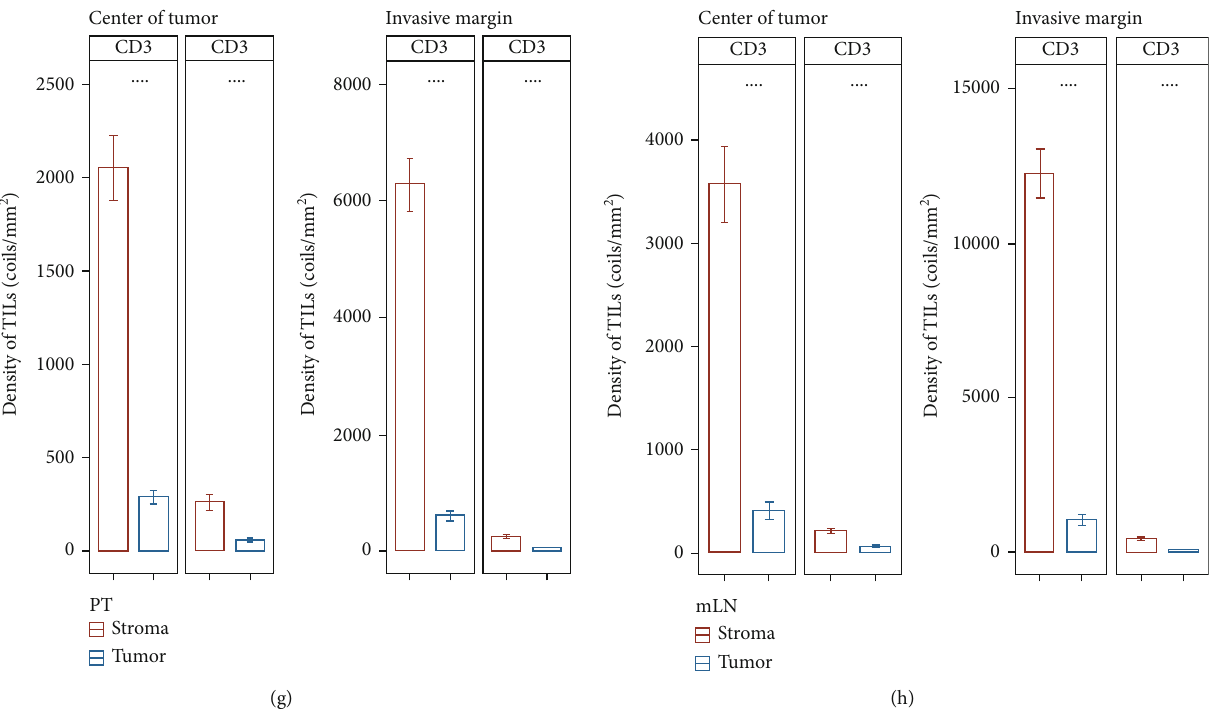
Figure 1: Multiplex immuno fl uorescence staining and multispectral imaging to visualize the expression of CD3, CD8, PD-L1, and cytokeratin (CK) in primary tumors (PTs) and metastatic lymph nodes (mLNs). (a) Fields of view (FOVs) of the center of tumor (CT) and invasive margin (IM) regions were identi fi ed at low magni fi cation ( × 10). (b) Images of representative FOVs that are categorized as CT in sections with tumor tissue being too small. (c, d) FOVs of CT region in PT (c) and mLN (d). Staining was performed for CD3 for T lymphocytes (yellow), CD8 for cytotoxic T cells (green), type II CK for epithelial cells (purple), 4 ′ -6 ′ -diamidino-2-phenylindole (DPAI) for nuclei (blue), and PD-L1 (red). (e, f) FOVs of IM region in PT (e) and mLN (f). Hand-drawn training regions allowed images to be segmented into tumor compartment (presence of cytokeratin positivity (red)) and stroma compartment (absence of cytokeratin positivity (green)). (g, h) Densities of CD3+ and CD8+ tumor-in fi ltrating lymphocytes (TILs) in tumor and stroma compartments of PT (g) and mLN (h) were assessed. Higher densities of CD3+ and CD8+ were observed in stroma compartment compared to tumor compartment in both PT and mLN. Signi fi cance was evaluated using a Wilcoxon signed-rank test. ∗∗∗∗ P < 0 : 0001 . Table 1: Clinicopathological